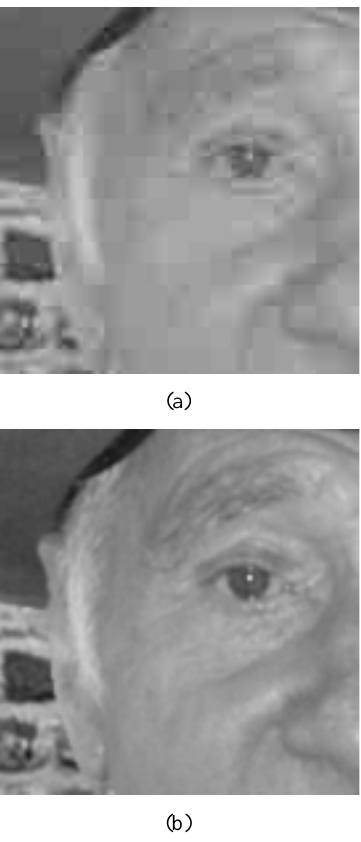
Figure 3. (a) A JPEG version (section on compression ratio of 7:1 and (b) the same using the contour nodes for a contour increm The proposed compression process was furt image of the lake (400 2 ) and the aerial vie Figure 4 and Figure 5 respectively. The maximum and minimum differences values resulting from subtracting the JPEG v from the original lake.tif were respectively scale values with an R.M.S. equal to +/-3 contour approach produced maximum and m equal to -35 and +37 respectively with an pixel grey-scale intensity values. On the other hand, the maximum and mini pixel intensity values resulting from sub version of aerial.jpeg view from the original respectively -35 and +47 grey-scale valu equal to +/-35. By contrast, the contour maximum and minimum differences equ respectively with an R.M.S. of +/- 7.8 pixel values.